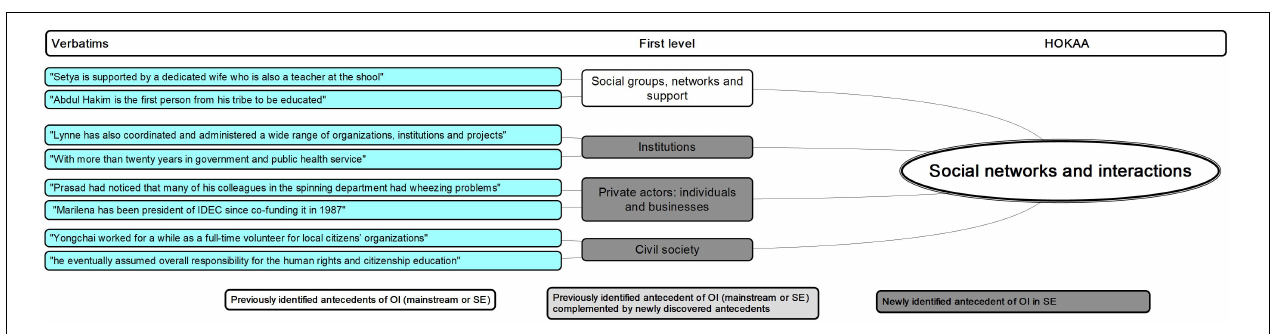
FIGURE 4 | HOKAA ‘Social networks and interactions’: emerging